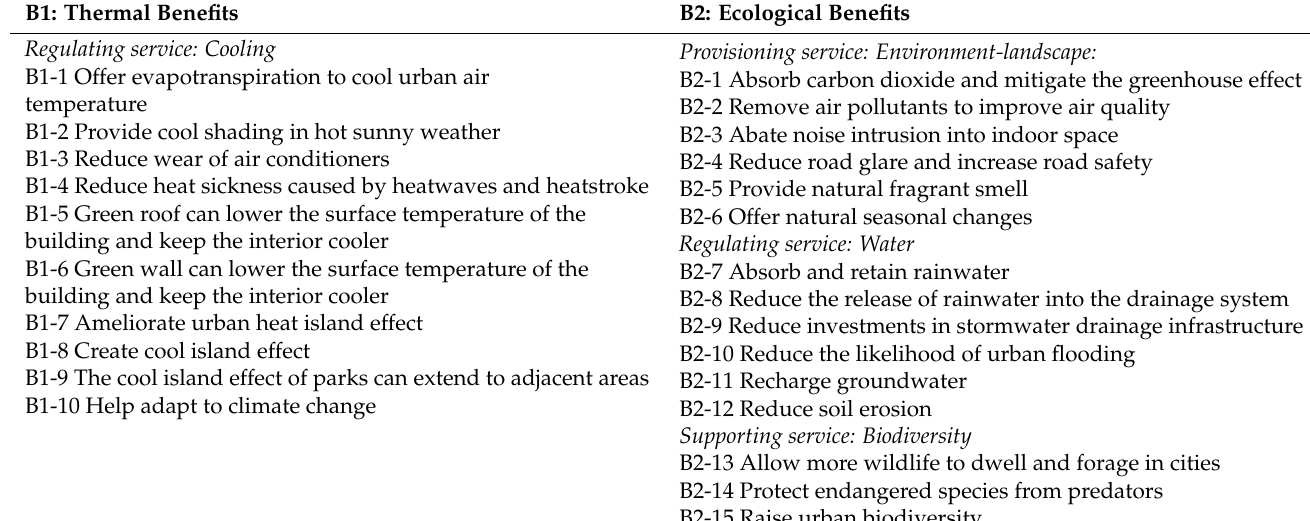
Table 1. Detailed classification of UGS thermal and ecological benefits adopted in the questionnaire